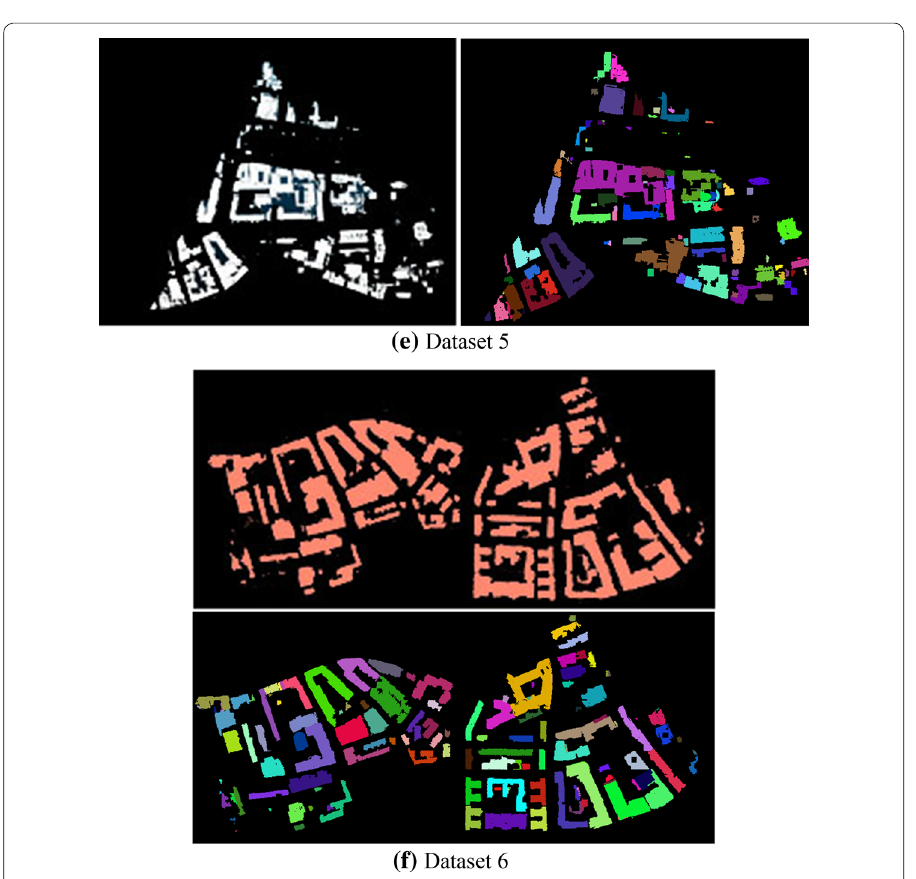
Fig. 9 Visualization of building segmentation using the Euclidean distance (Dataset 5 and